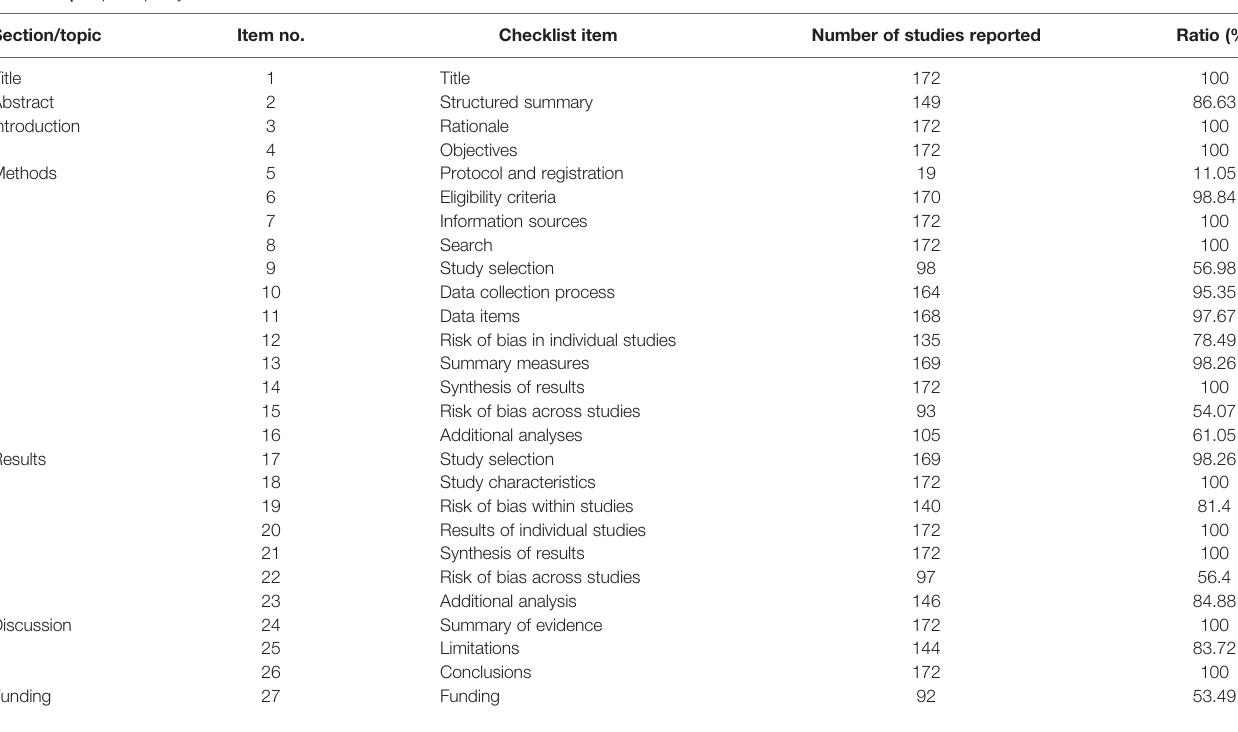
TABLE 1 | Report quality of included studies.